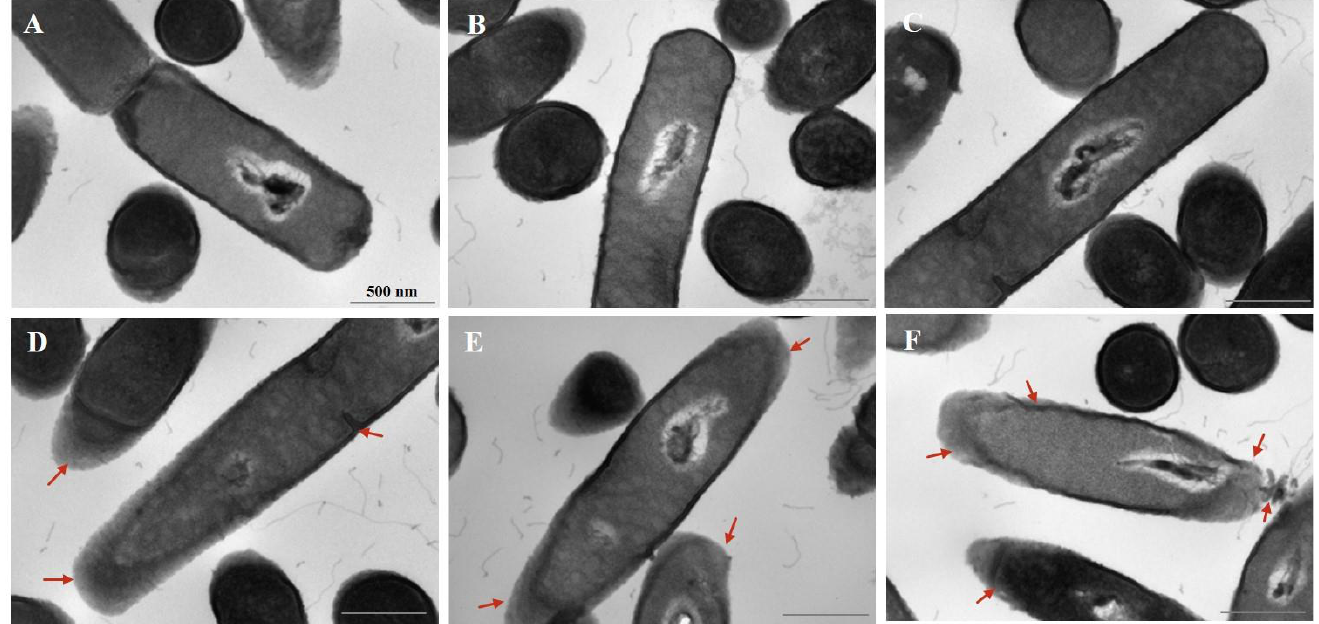
Figure 4. Transmission electron microscope image of B. subtilis after PDT treatment. ( A ) Untreated group; ( B ) single LED light group; ( C ) single 50 μmol/L curcumin group; ( D ) The treatment with 10 μmol/L curcumin for the illumination time of 12 min; ( E ) The treatment with 30 μmol/L curcumin for the illumination time of 12 min; ( F ) The treatment with 50 μmol /L curcumin for the illumination time of 12 min. The scale bar in the panel is 500 nm and all panels have the same magnification. Red arrow indicates the damaged cell